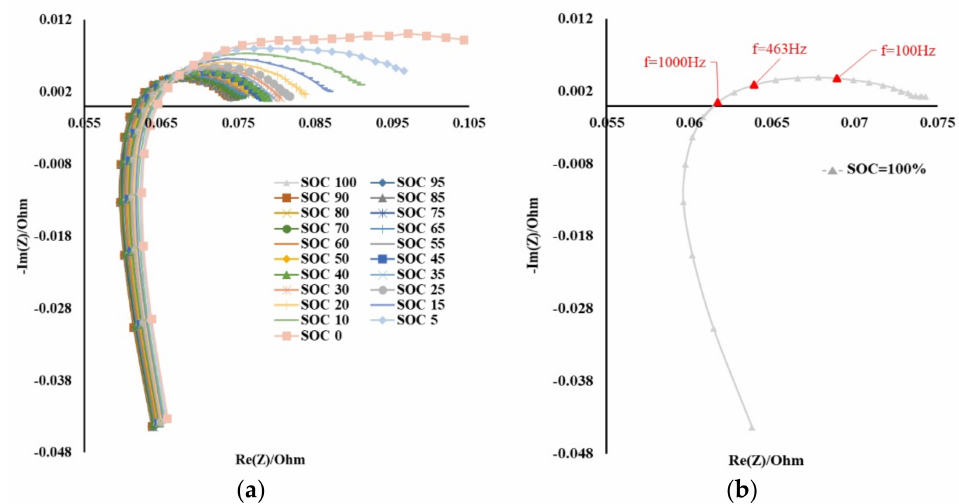
Figure 5. Nyquist plot when using 0.2 C-rate discharge: ( a ) Nyquist plot of 0% to 100% SOC; ( b ) AC impedance under 3 different frequency.